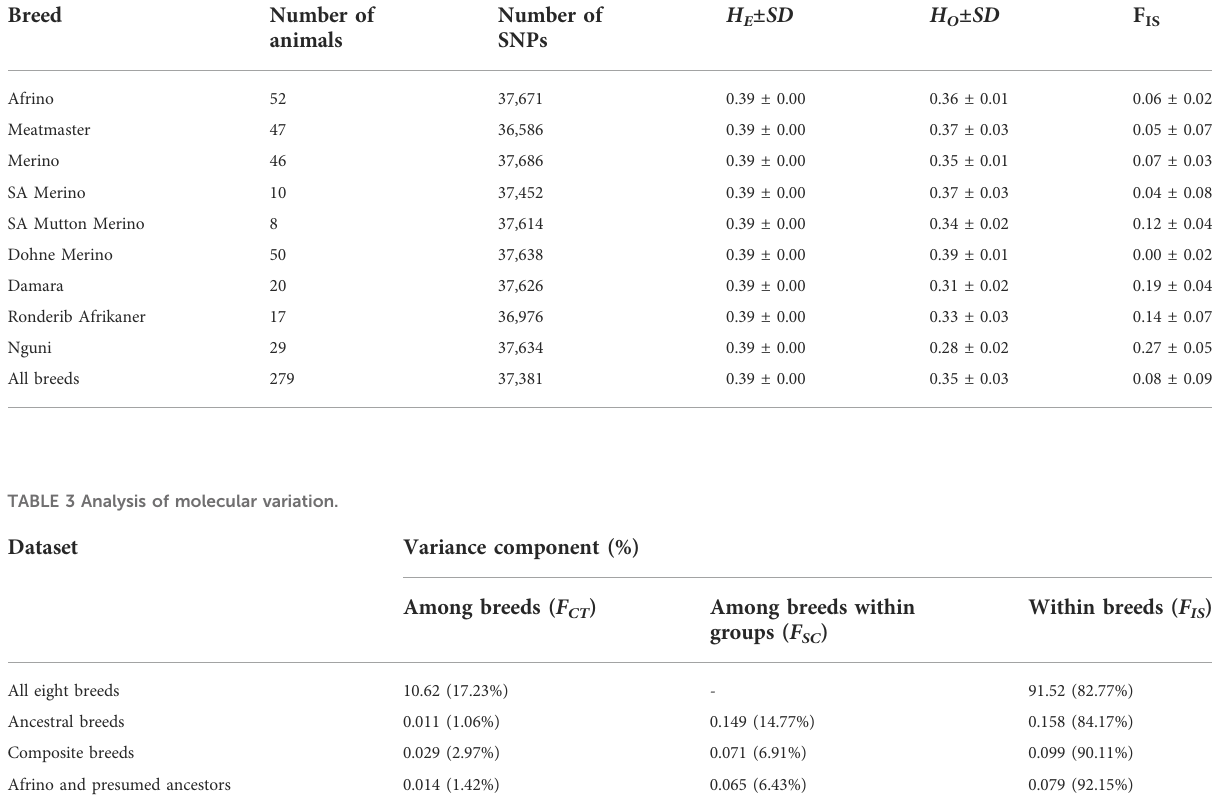
Table S4). All fi ve of the selection sweep regions identi fi ed using